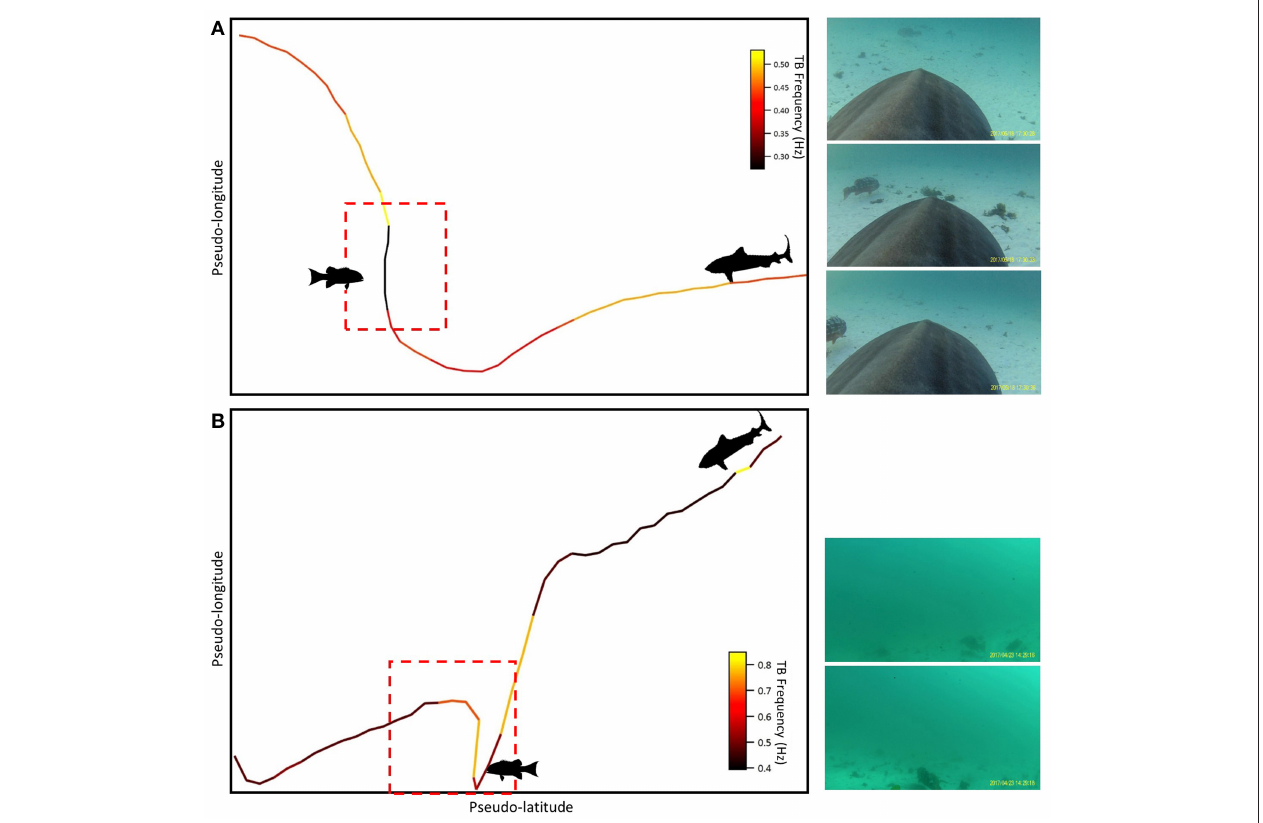
FIGURE 4 | One minute pseudo-tracks of tiger shark interactions with Chinamanfish ( Symphorus nematophorus ). Track line is colored by tailbeat frequency (Hz). Red dashed square indicates where the fish was observed in the video field of view (displayed in screenshots to the right of the pseudo-track). X and Y-axes represent arbitrary units of latitude and longitude created by magnetometer and accelerometer data whilst a constant speed is assumed. (A) Example of an interaction where the tailbeat of the shark slows upon encountering the fish. (B) Example of an interaction where the tailbeat of the shark quickens upon encountering the fish. As constant speed was used to estimate pseudo-tracks, we caution that speed changes throughout the sampling period by tagged sharks may slightly influence the shape of resulting